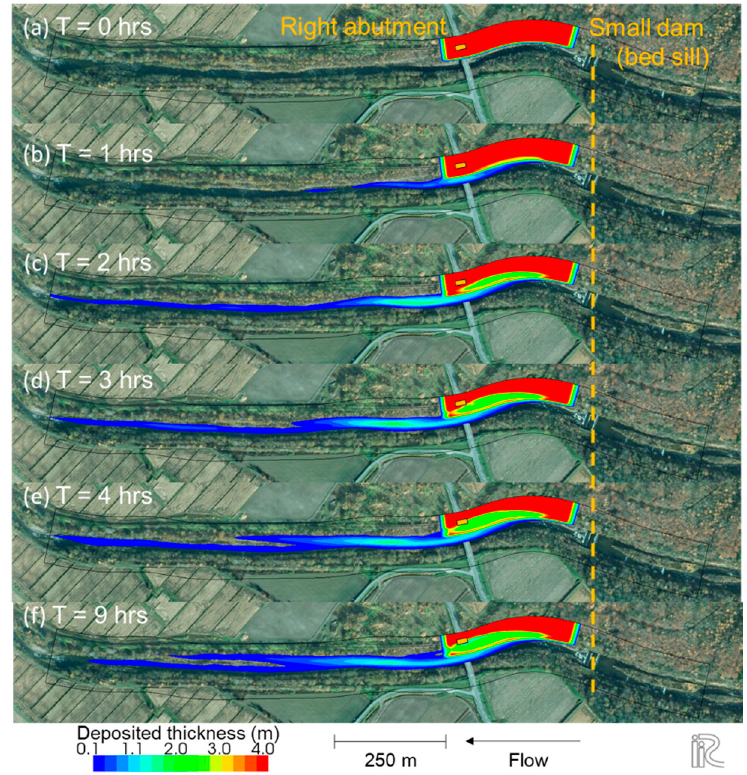
Figure 9. Temporal variation of the deposited thickness of the sediments on the right bank. The yellow square indicates the right abutment.